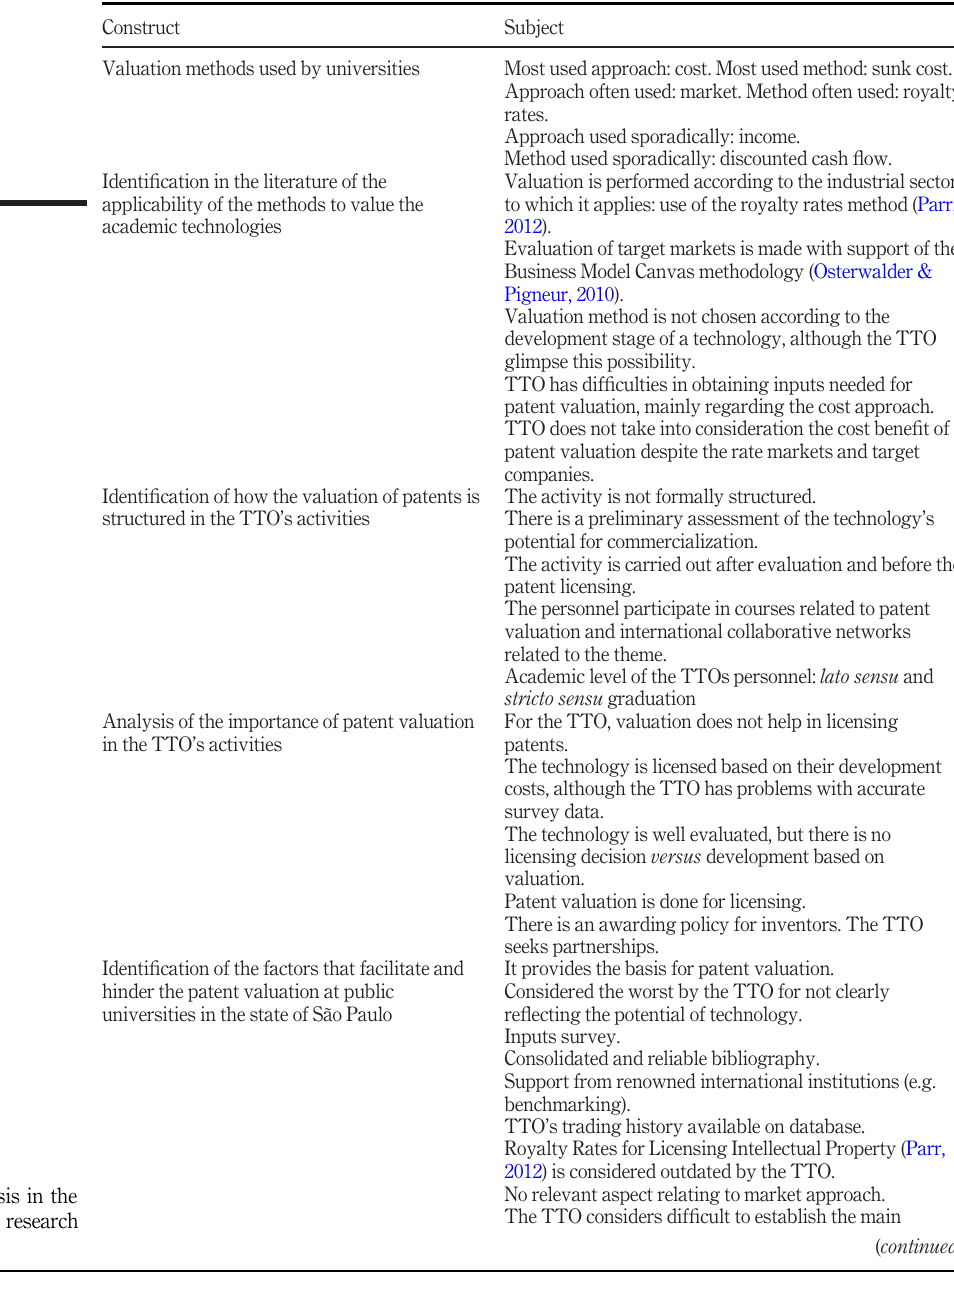
Table 3. Case analysis in the light of the research